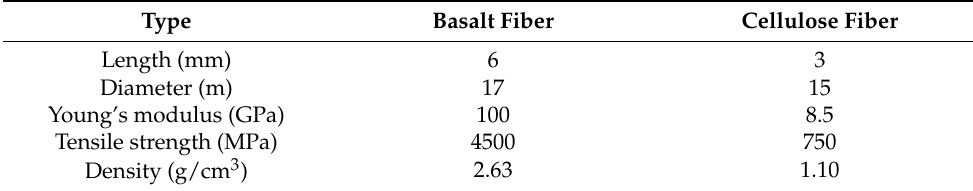
Table 2. Physical properties of cellulose and basalt fiber used in the present investigation *. Type Basalt